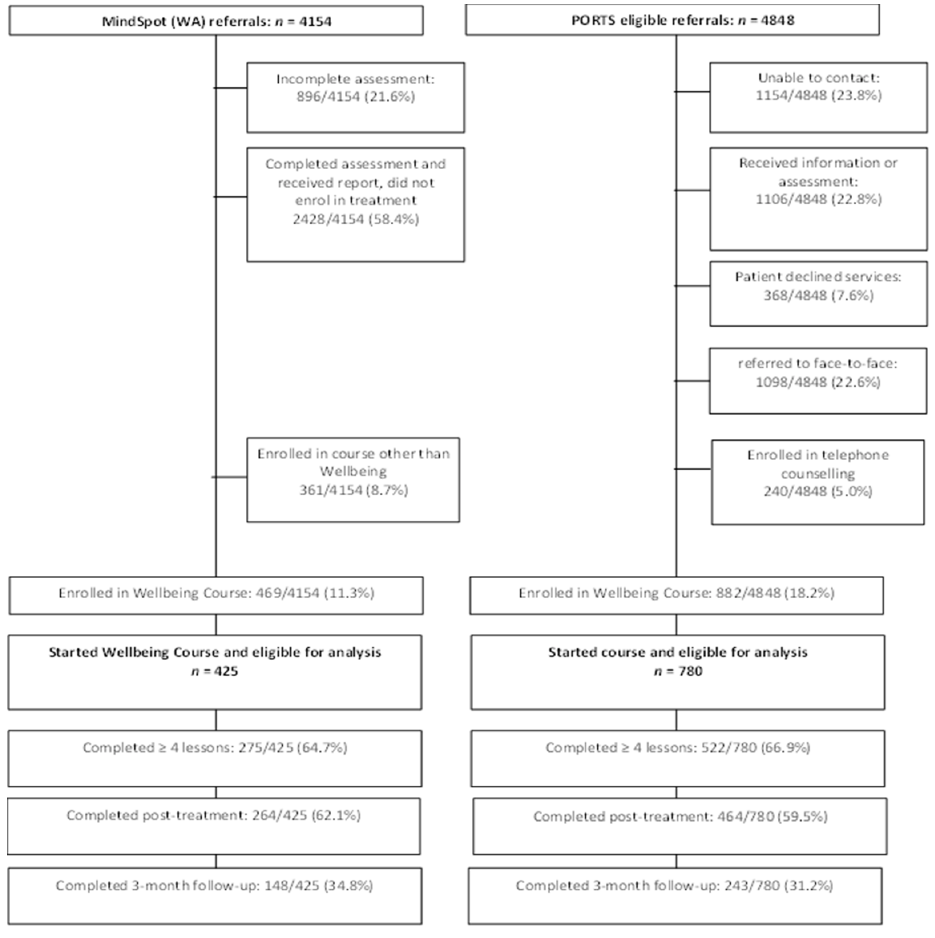
Figure 1. Patient